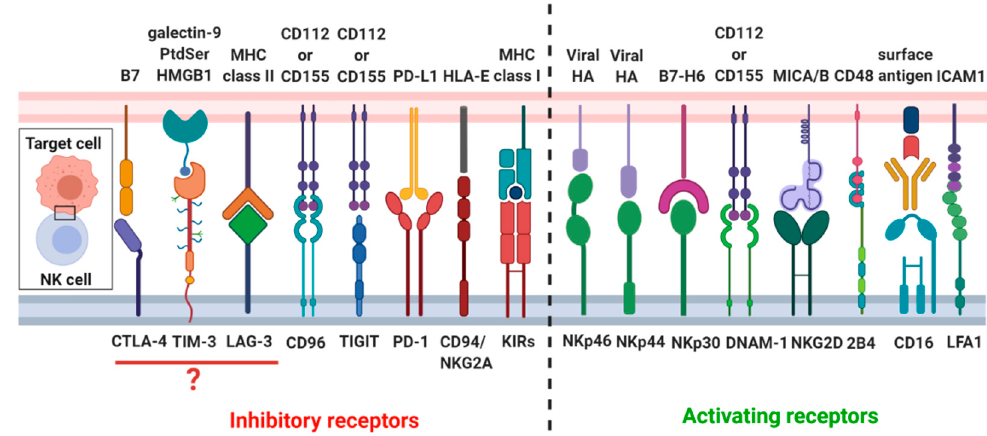
Figure 1. Overview of the NK cell receptors and their respective ligands. NK cells’ cytotoxicity is tightly regulated through the complex balance between inhibitory and activating signals originating from different NK cell